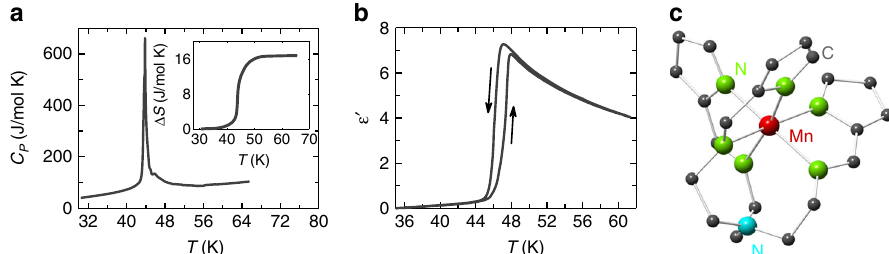
Fig. 1 Physical properties of Mn(taa) at the temperature- induced SST. a There is a sharp peak in the heat capacity C p vs temperature T at the SST in Mn (taa). The inset shows the corresponding entropy change Δ S . b The dielectric constant ϵ ′ as a function of temperature also shows a sharp transition at the SST above which Curie-Weiss-like paraelectric behavior continues up to room temperature in our data and the literature 26,31 . c A molecule of Mn(taa) with Mn 3 + in a quasi-octahedral Nitrogen (green) environment. A seventh non-bonded Nitrogen is shown in blue. The standard errors due to random noise are smaller than the line